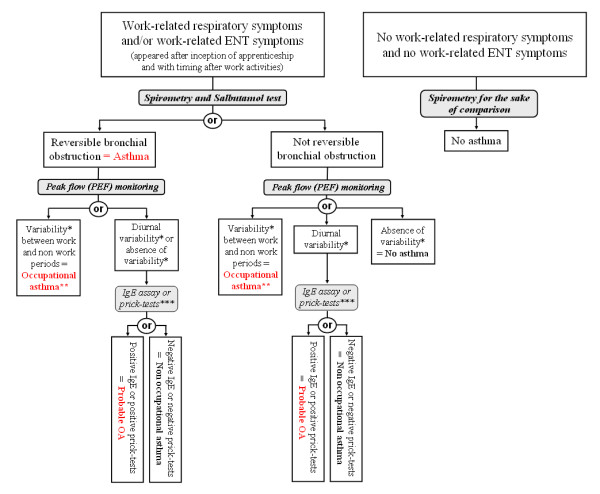
Decision tree for the definition of occupational asthma. * Variability is defined by the Oasys-2 score as deterioration during a work period or improvement during a period away from work of at least 20%. ** When only ENT symptoms are present, the diagnosis of infraclinic OA is more appropriate. *** IgE Assay (bakers and pastry makers) and prick-tests (hairdressers) were realized for specific occupational allergens.